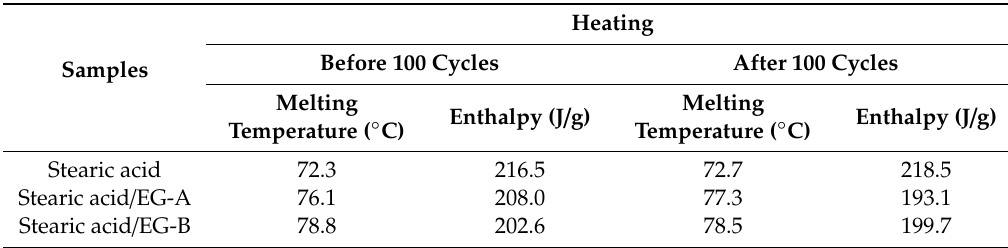
Table 1. Di ff erential scanning calorimetry (DSC) data of stearic acid and stearic acid / EG composites during heating.